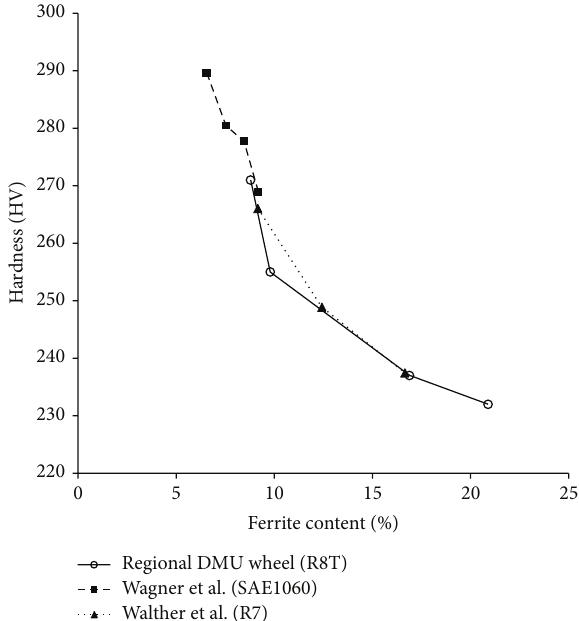
Figure 21: Relationship between PE ferrite fraction and hardness.